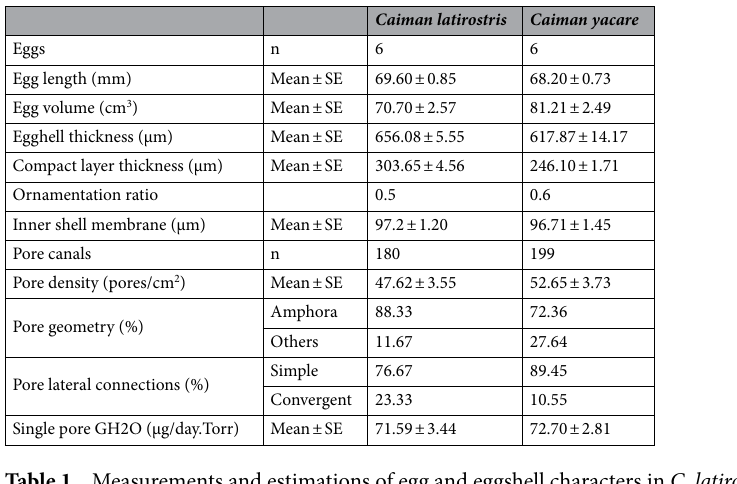
Table 1. Measurements and estimations of egg and eggshell characters in C. latirostris and C. yacare . See also Supplementary Table S2.